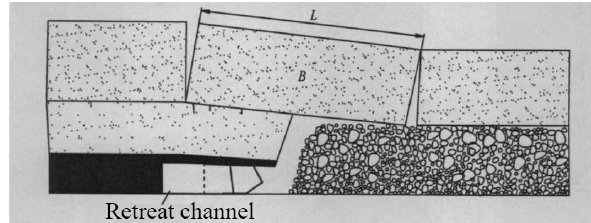
Fig. 1 Support design of main retracement